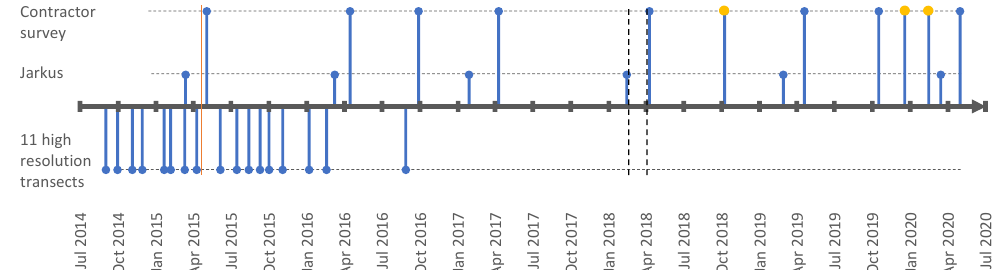
Figure 3. Timeline of the survey data. Three datasets are used: 1. JARKUS surveys covering the full coastal cell; 2. Contractor surveys covering the 9 km project site; 3. Contractor transect surveys of 11 profiles with high temporal resolution shortly after the construction period. Red vertical line indicates the formal end of construction; black vertical lines bound the additional 2018 beach nourishment period. Yellow dots indicate subaerial surveys; blue dots indicate surveys that include both subaerial and subaqueous